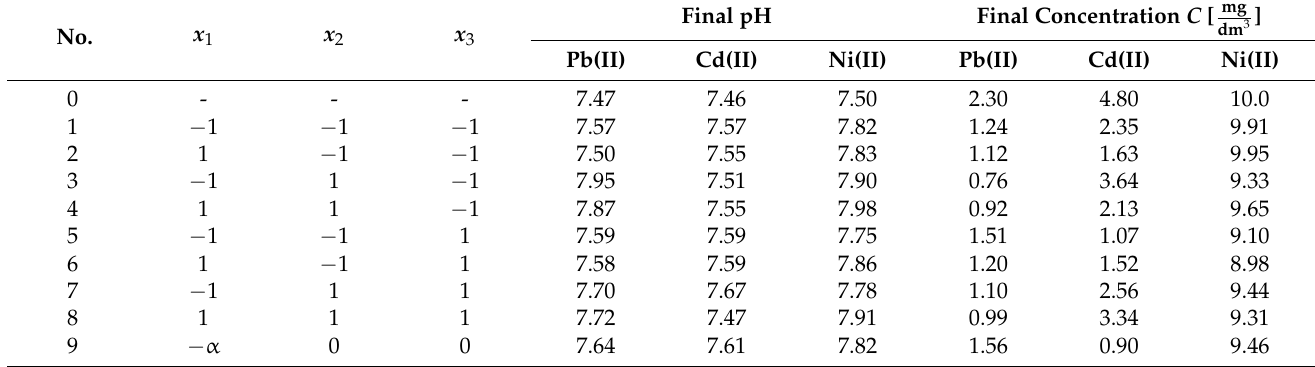
Table 4. Measurement results for pH and metal ion concentration at points in the CCI measurement